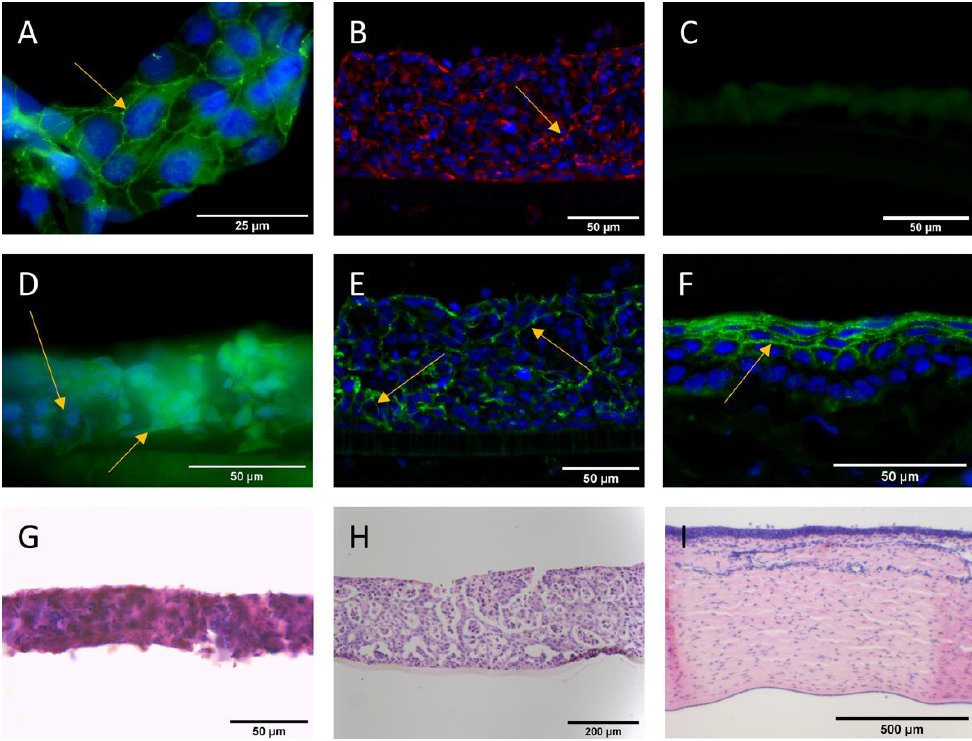
Figure 2. Immunocytochemistry and histology of in vitro corneal models and rabbit cornea. Immunofluorescent staining for zonula occludens-1 (ZO-1) protein expression (green) in HCE-T multilayers grown on top of the collagen hydrogel ( A ), human corneal epithelial cells (HCE-T) grown on conventional cell culture insert (red) ( B ). Negative control of occludin for HCE-T cells grown on top of hydrogel ( C ). Immunofluorescent staining for occludin (green) in hydrogel-based in vitro corneal mimetic ( D ), HCE-T cells grown in the insert ( E ), and rabbit cornea ( F ). Nuclei are stained with DAPI (blue) ( A – F ). Yellow arrows indicate the tight junctional staining between the cells. Hematoxylin and eosin-stained sections of HCE-T multilayers grown on top of the collagen hydrogel ( G ), HCE-T cells grown in the insert ( H ), and rabbit cornea ( I ).